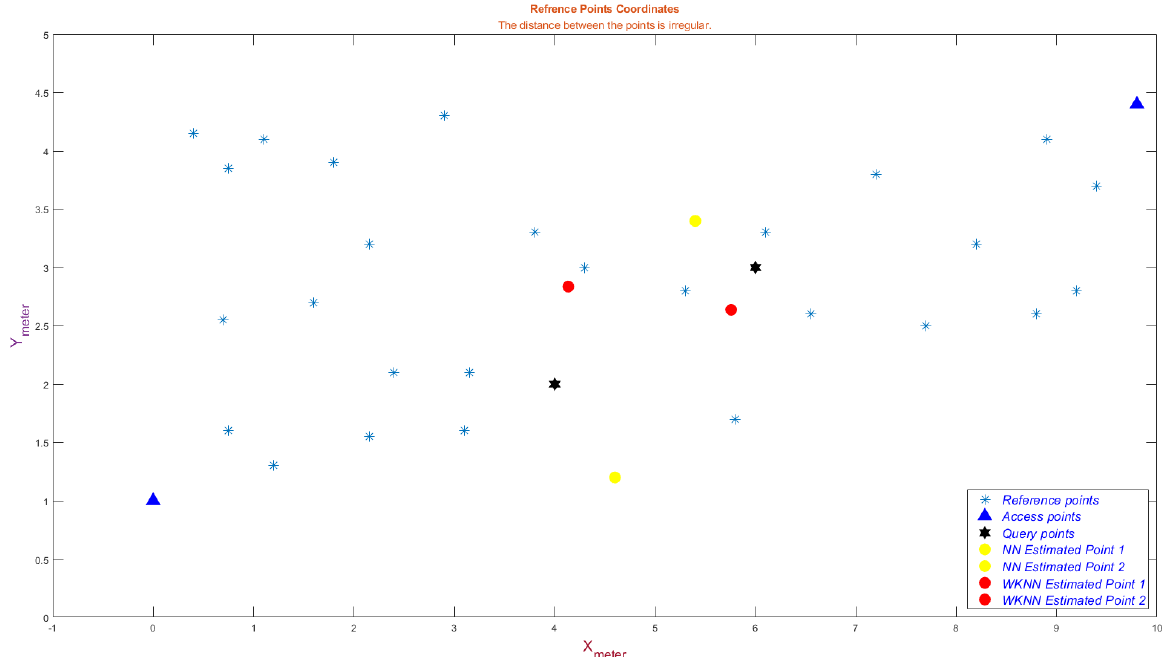
Figure 9 . A view of determining the position of the Target points by different methods in the second scenario (Blue stars are reference points, triangles are access points, black stars are target points, yellow circles are estimated points from NN method and red circles are estimated points from